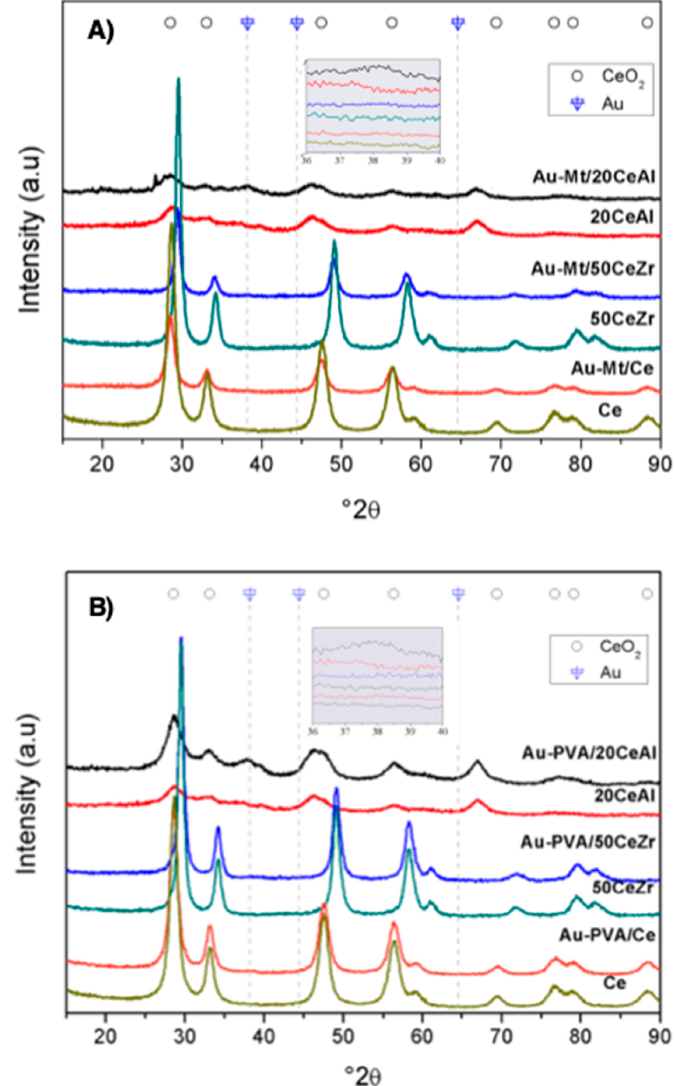
Figure 1. X-Ray diffractograms of supports and catalysts: ( A ) Mt- and ( B ) Polyvinylalcohol (PVA)-protected solids, insets zoom on Au (111)